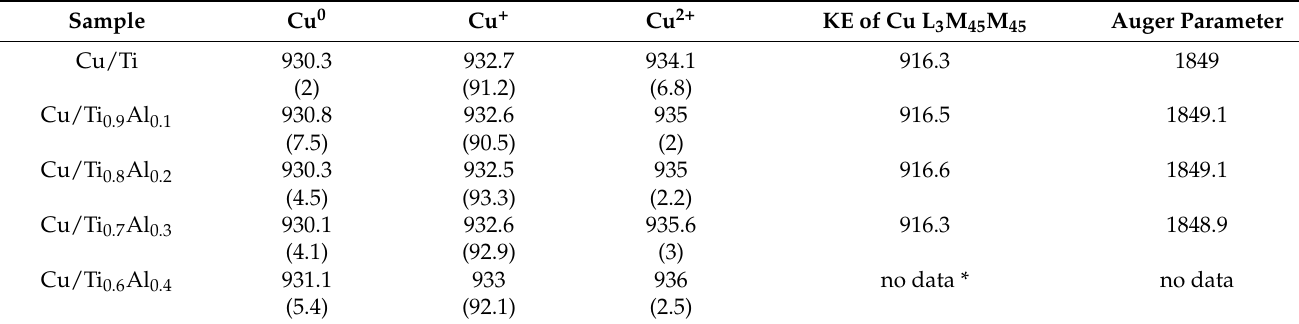
Table 5. Spectral fitting parameters for Cu 2p 3/2 lines of fresh catalysts: binding energy (eV) and percentage of total area (in parentheses). The kinetic energy of CuLMM and Auger parameter are also listed.